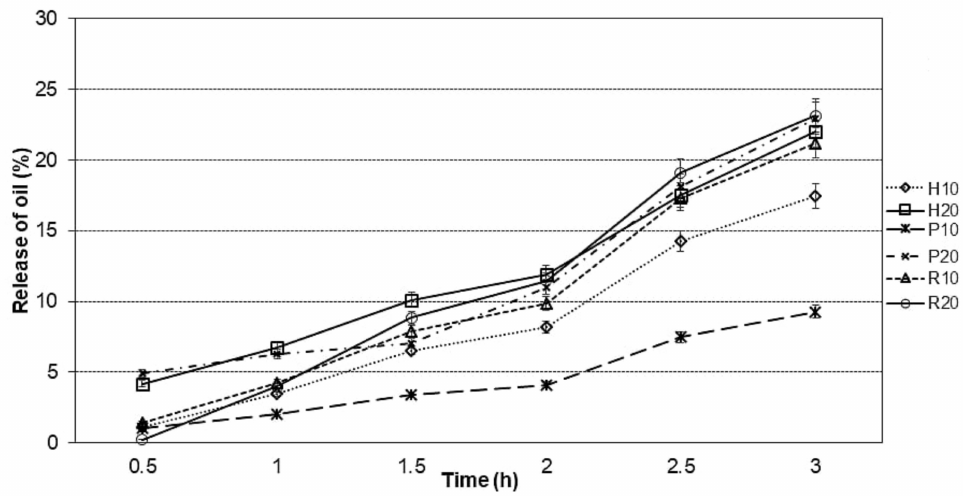
Figure 2. Oil release from hempseed oil microcapsules encapsulated with combination of proteins with